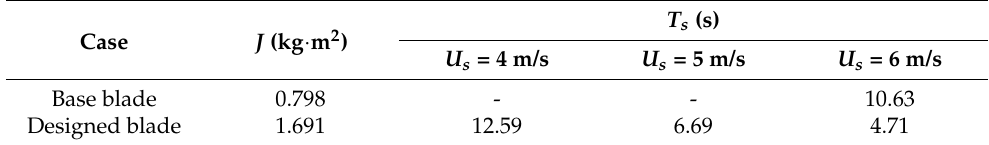
Table 4. The T s values of the base and designed blades at various wind speeds.